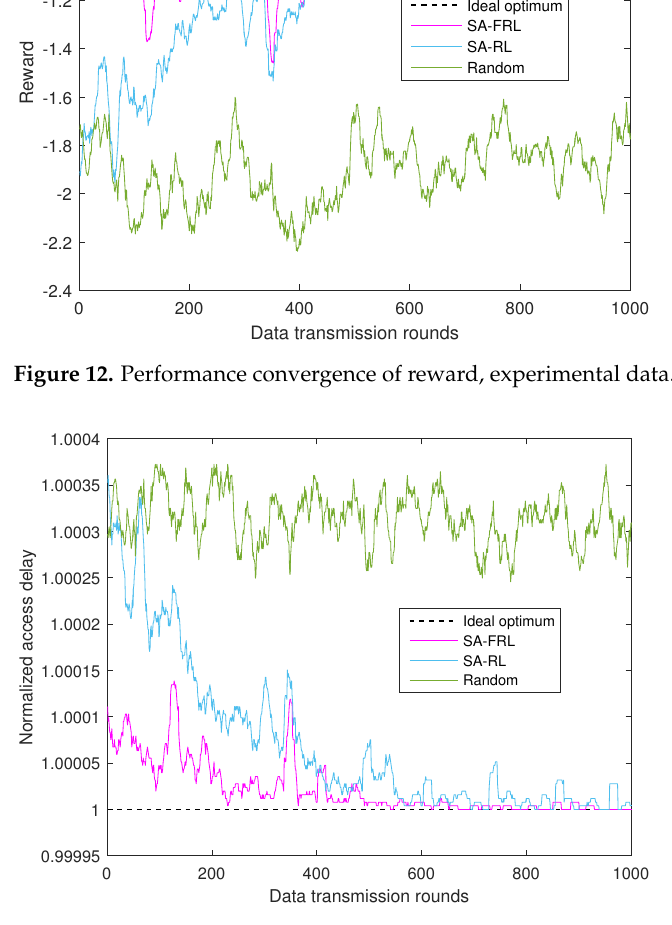
Figure 13. Performance convergence of access delay, experimental